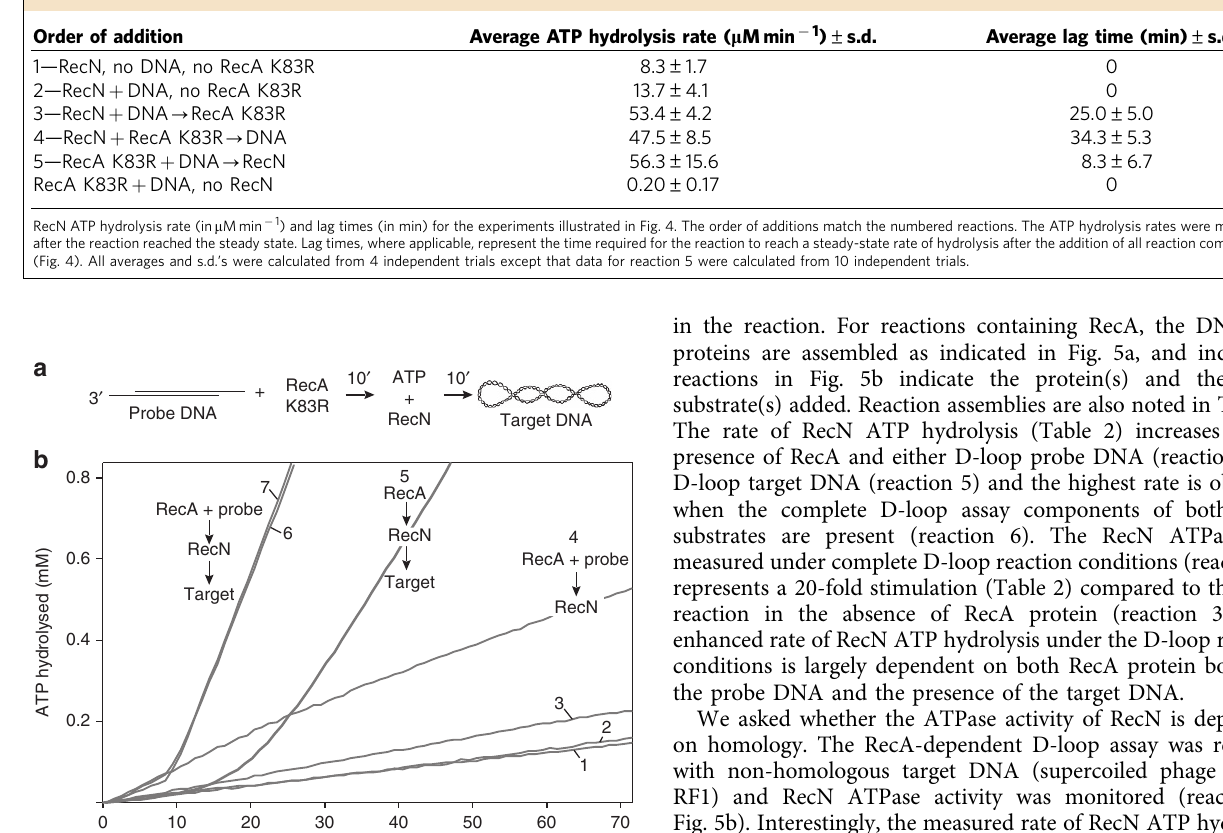
mediating D-loop formation, as has been shown for other RecA Walker A mutant homologues (Supplementary Fig. 4 and ref. 24).